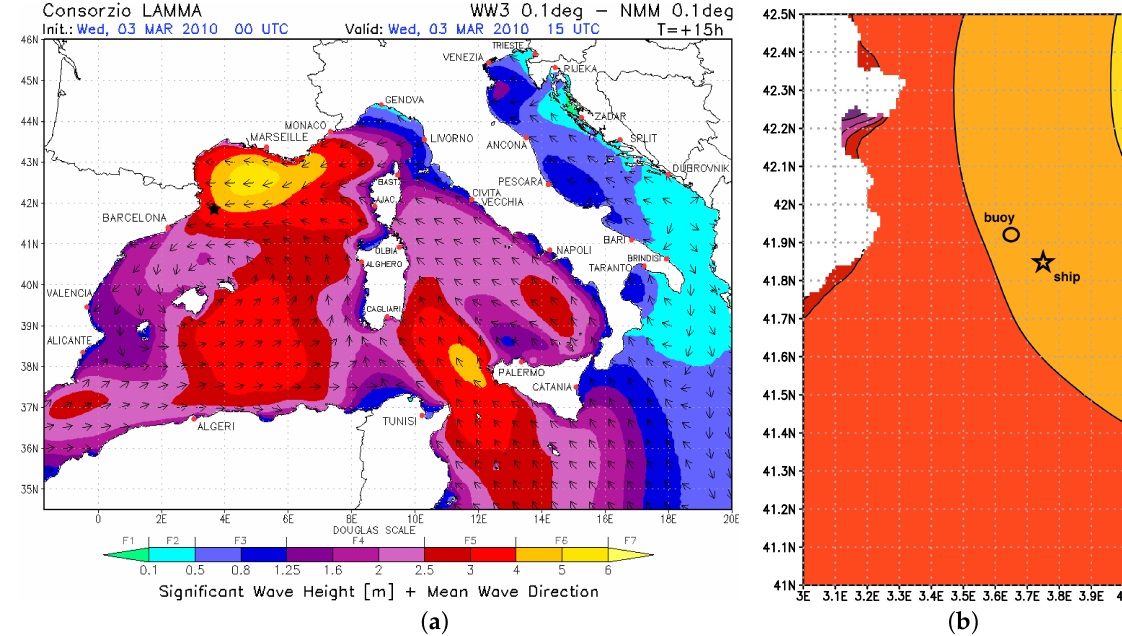
Figure 1. Significant wave height and mean wave direction on the northwest Mediterranean Sea on 3 March 2010 at 3:00 p.m. UTC ( a ), and zoom on the area of the accident ( b ). The star indicates ship position, the circle indicates Begur buoy